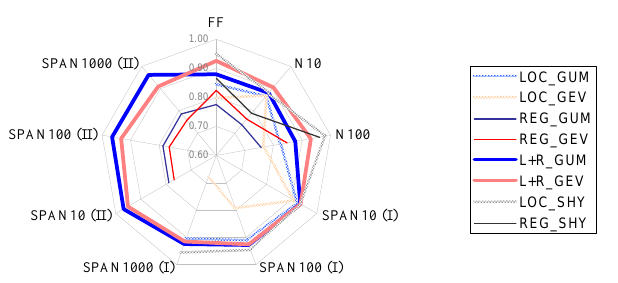
Fig. 8. Summary of reliability and stability scores for all imple-